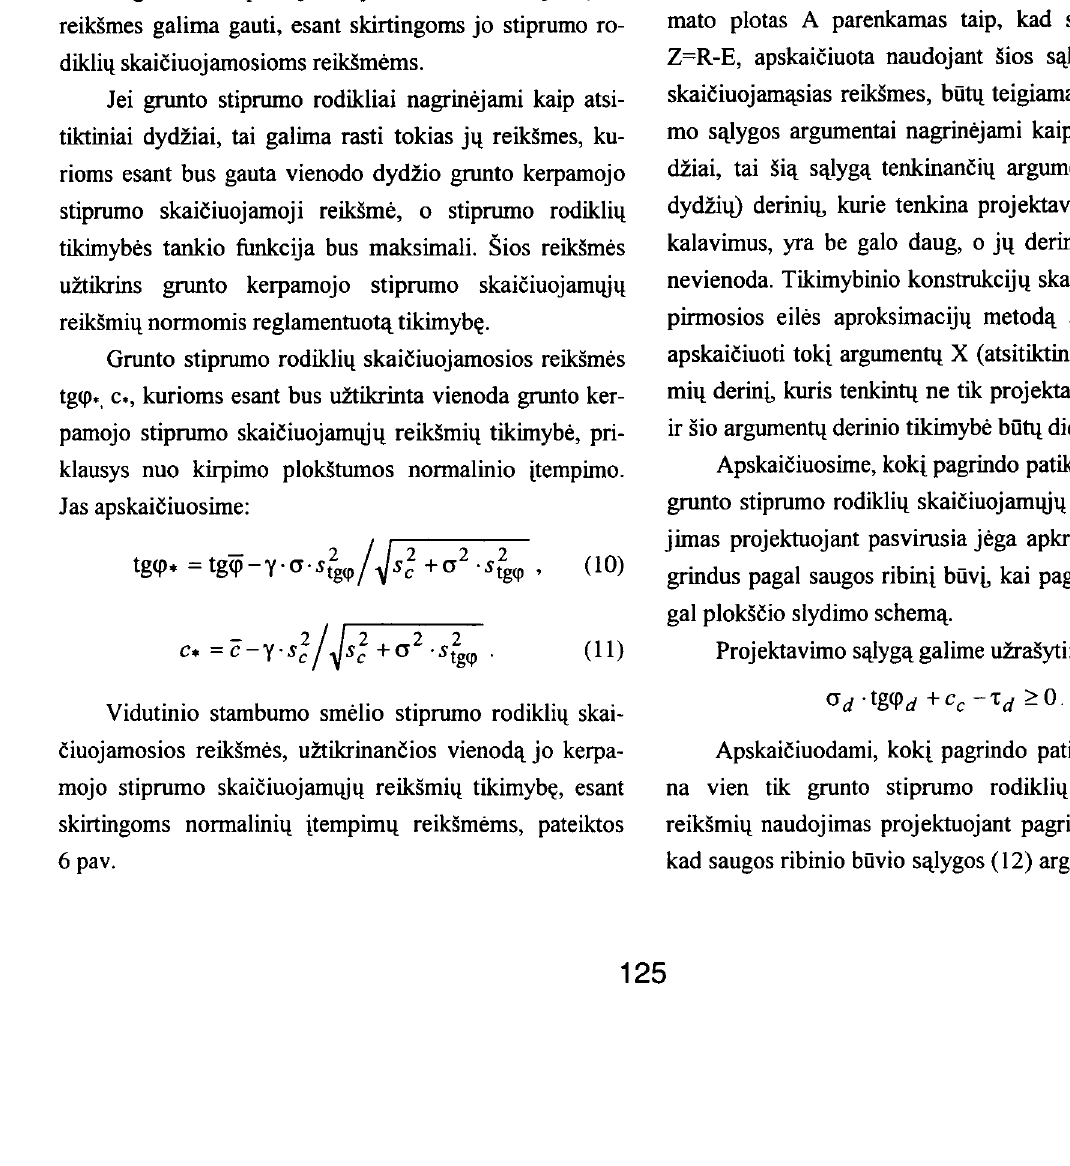
Fig 6. Design values of angle of internal friction and co hesion for the same probability of shear strength Kai grunto stiprumo rodikliq skaiciuojamosios reiksmes priklauso nuo normaliniq itempimq dydZio, tai jas sudetingiau panaudoti pagrindams projektuoti, nes siuo atveju pamatq pagrindams apskaiciuoti reikia taikyti tikimybinius